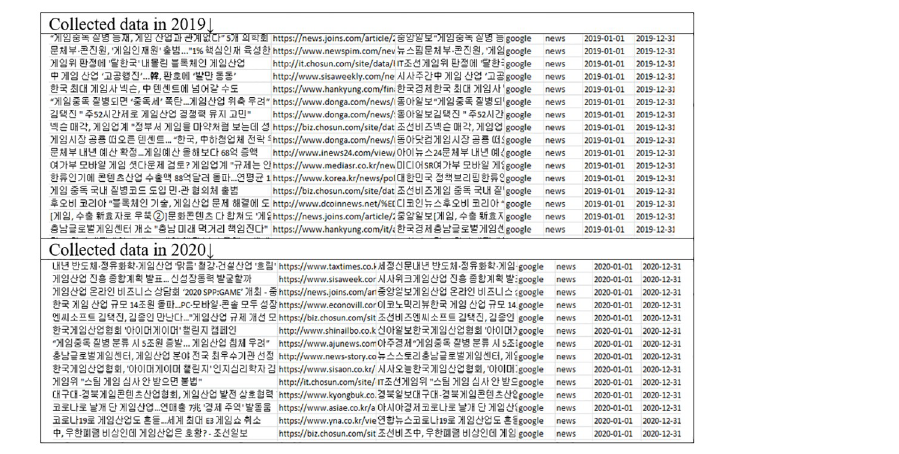
Fig 5. The collected